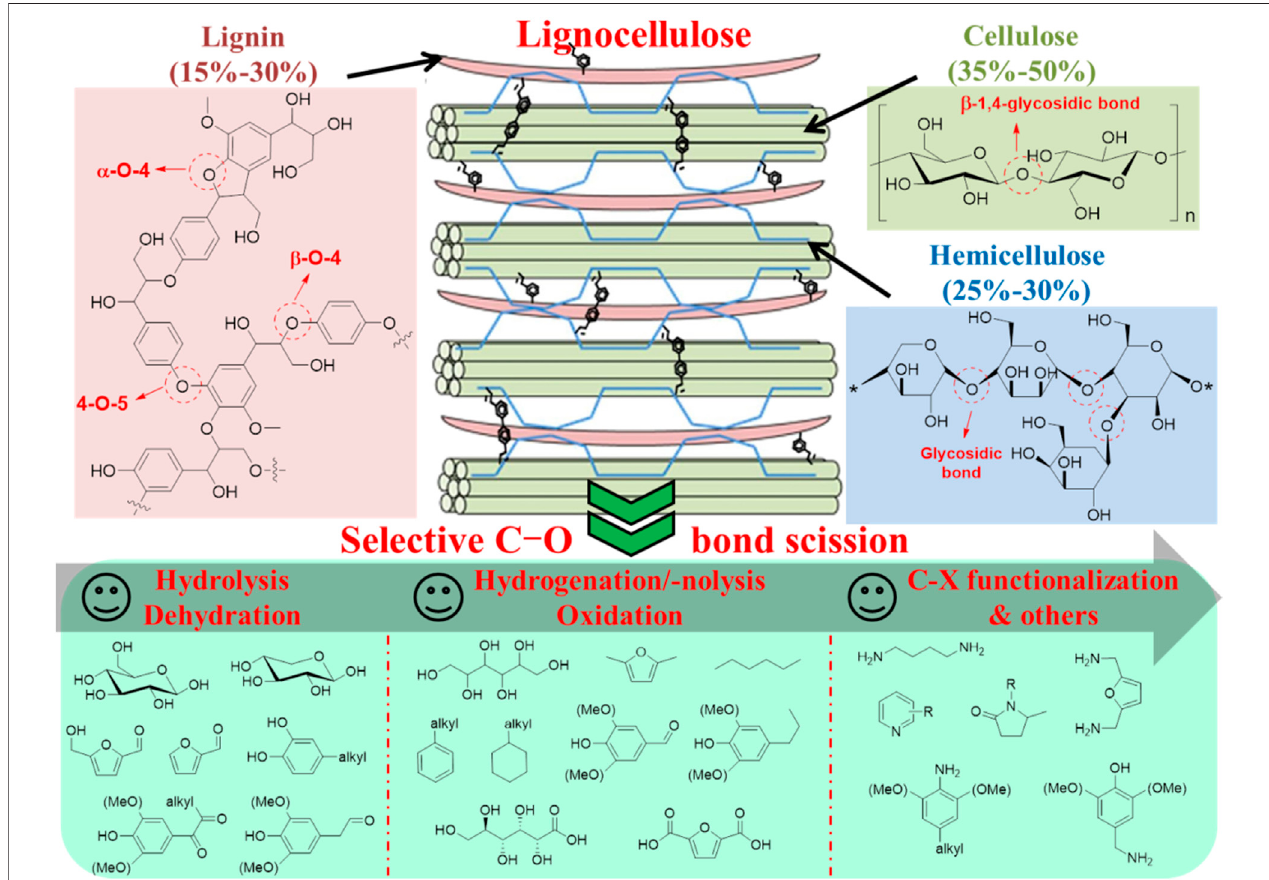
FIGURE 1 | The schematic of biomass valorization via selective C – O bond scission.